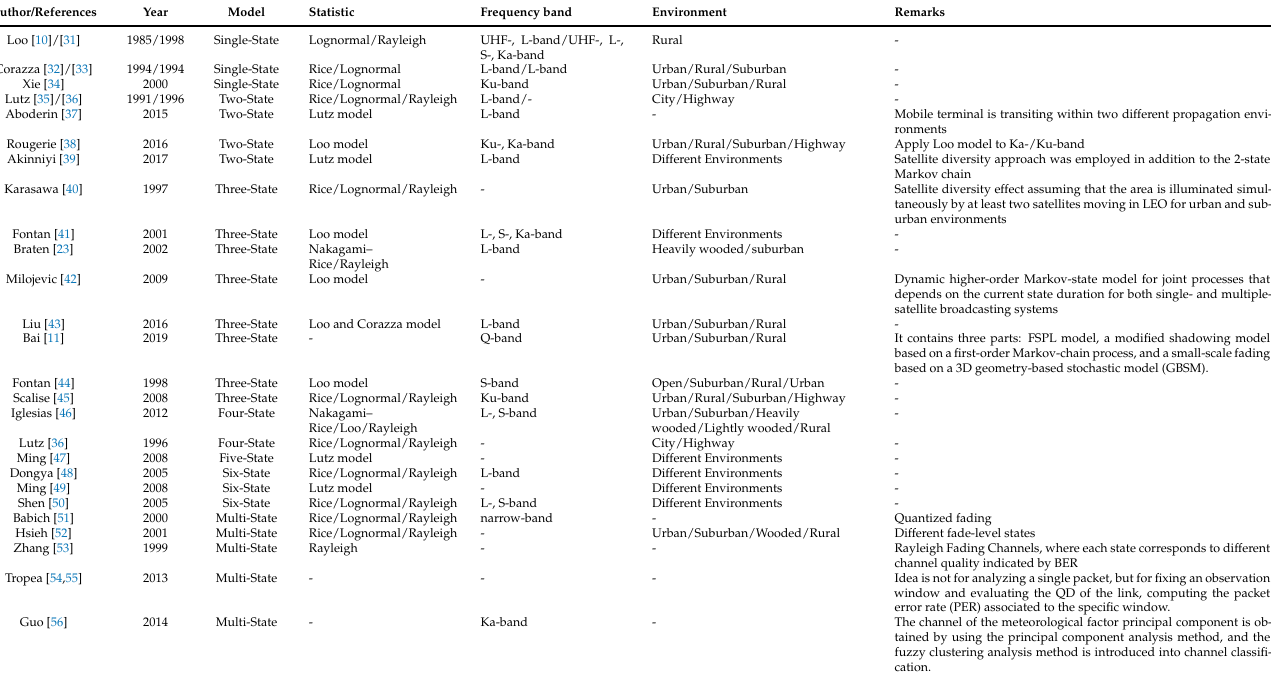
Table 5. LMS Channel models,